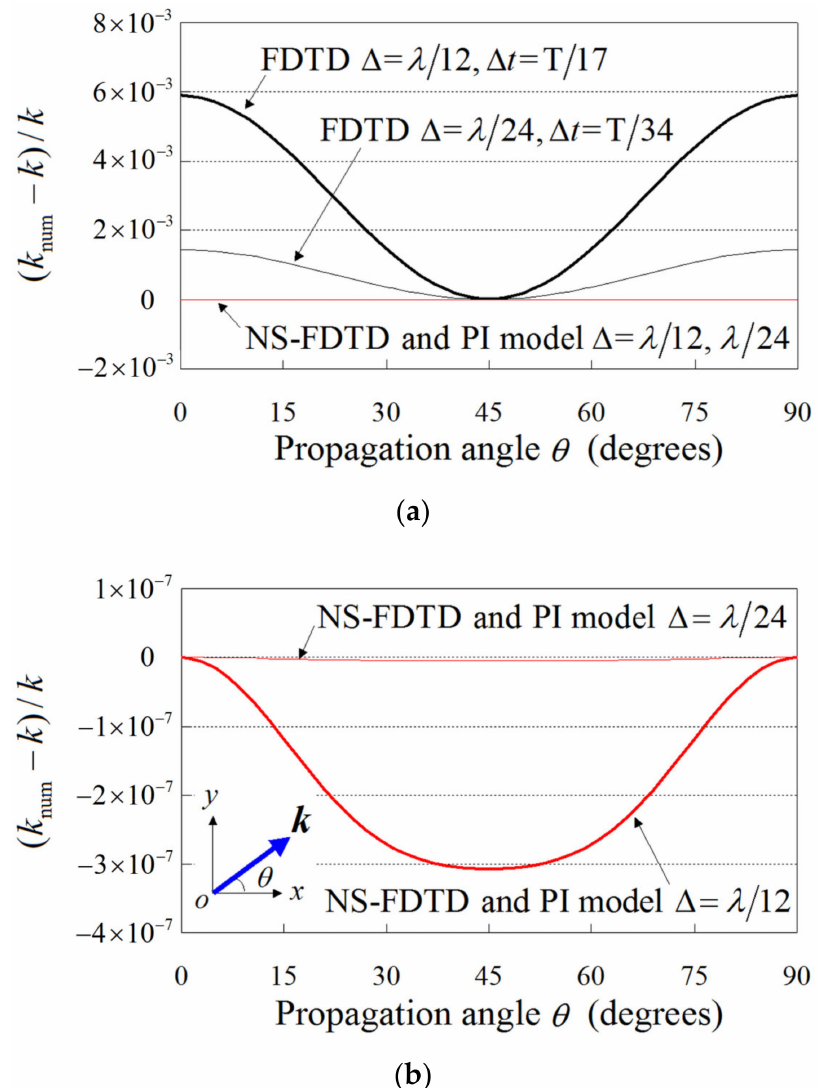
Figure 2. Numerically computed wavenumber, k num , versus propagation angle θ for the FDTD method, the NS-FDTD technique, and the proposed 2D PI model. ( a ) General comparison and ( b ) detail of the previous plot only between the NS-FDTD method and the PI model. In the analysis, k is the physical wavenumber, the wavelength is chosen to be λ = 1, ∆ is the grid size, and T = 2 π / ω . Note that the NS-FDTD method and the PI model have practically the same accuracy, which is almost four orders of magnitude higher (or even more) than that of the FDTD